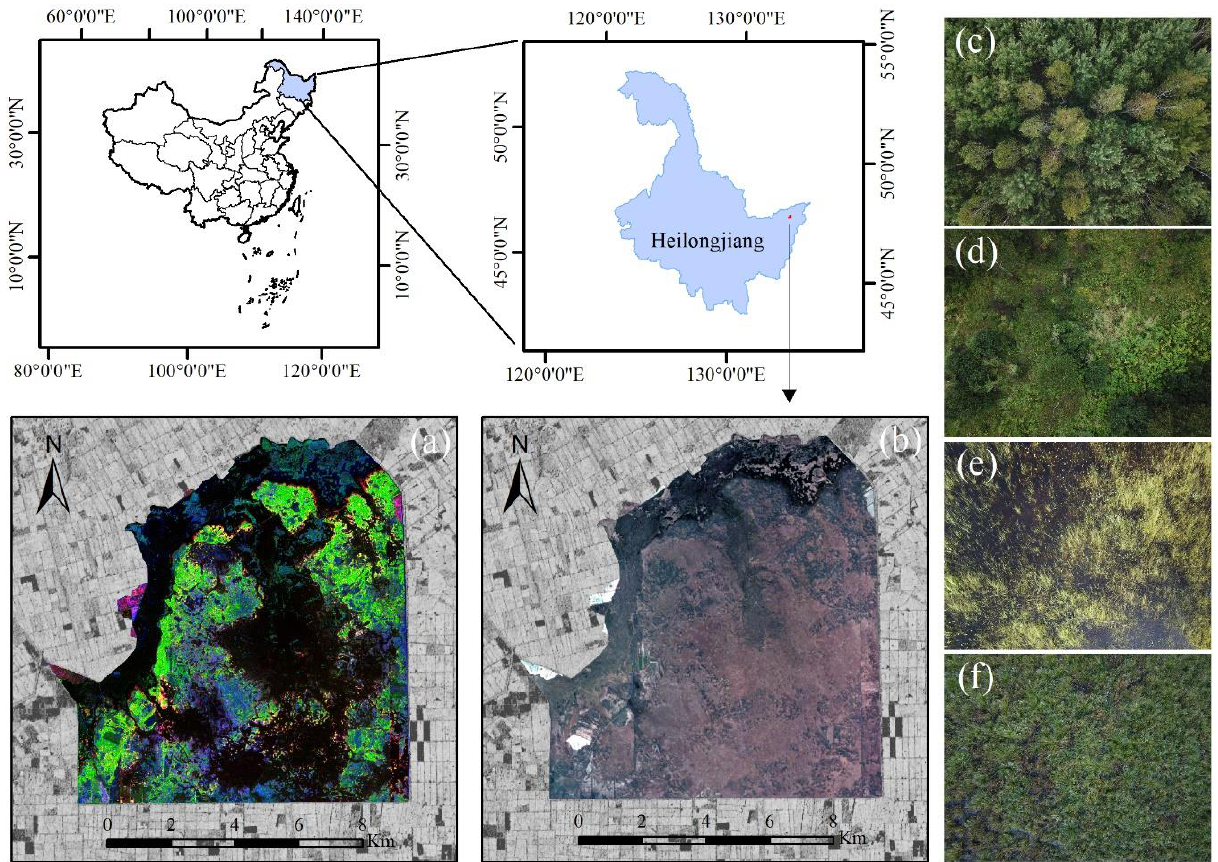
Figure 1. The geographical location of the study area. ( a ) False-color composite image of ALOS-2 based on Freeman2 polarimetric decomposition; ( b ) true-color image of ZH-1 hyperspectral satellite; ( c ) forest; ( d ) shrub; ( e ) deep-water marsh vegetation; and ( f ) shallow-water marsh vegetation. Table 1. Summary of main parameters of active and passive remote sensing